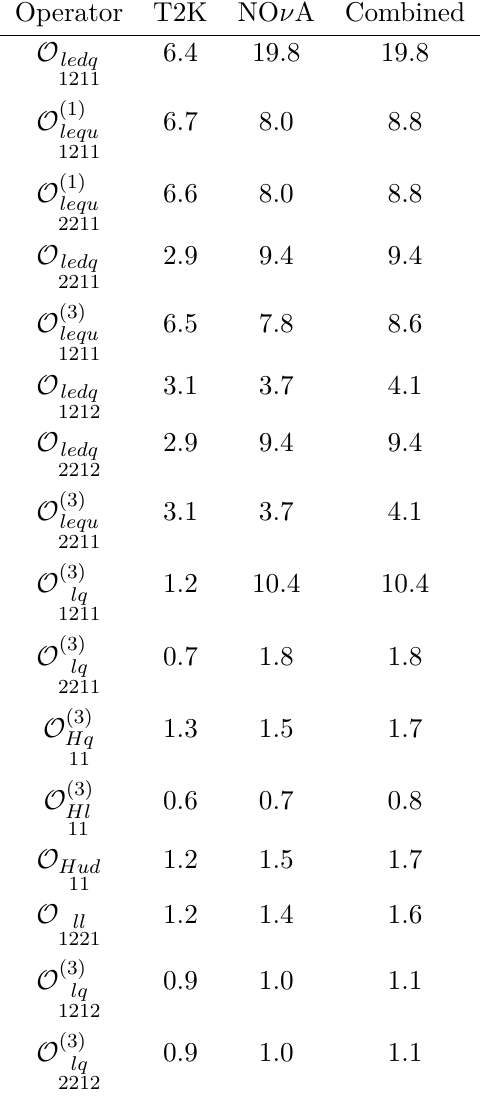
Table 5 . Lower bounds on the UV scale Λ as obtained from the long-baseline neutrino experiment data. The results are arranged from strongest to weakest. The constraints are provided in units of TeV at 95% CL significance for T2K and NO ν A, both individually and